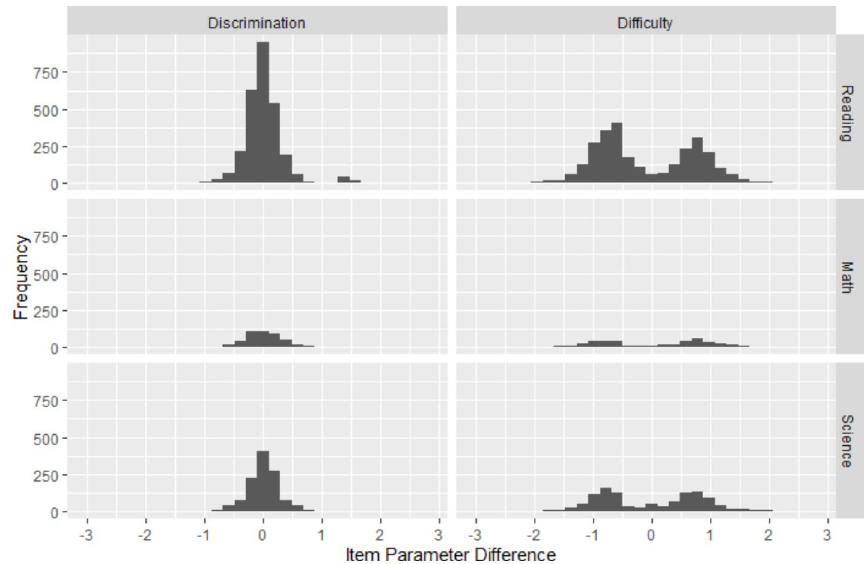
Fig. 3 The distribution of the PISA item parameter differences for DIF